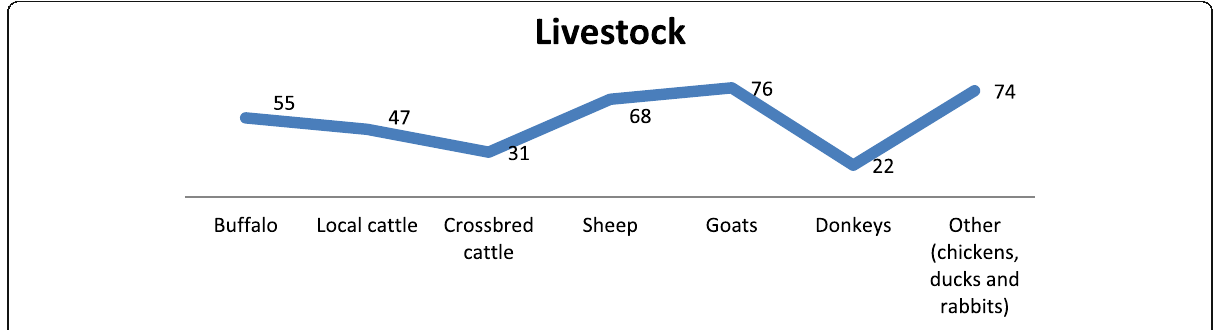
Fig. 1 Importance of livestock to farmers in rural areas of the Nile Delta in Egypt